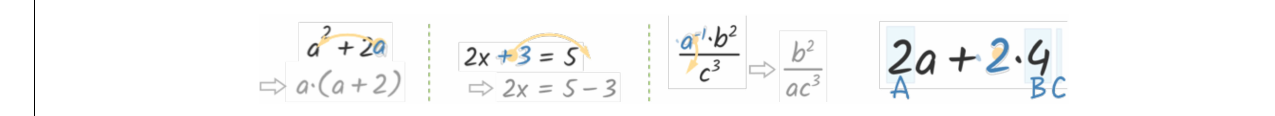
FIGURE 7 | The Graspable Math dynamic algebra notation interface: examples of gesture–actions for factoring, rewriting equations, and inverting powers with negative exponents. Results of gesture–actions are depicted in gray.